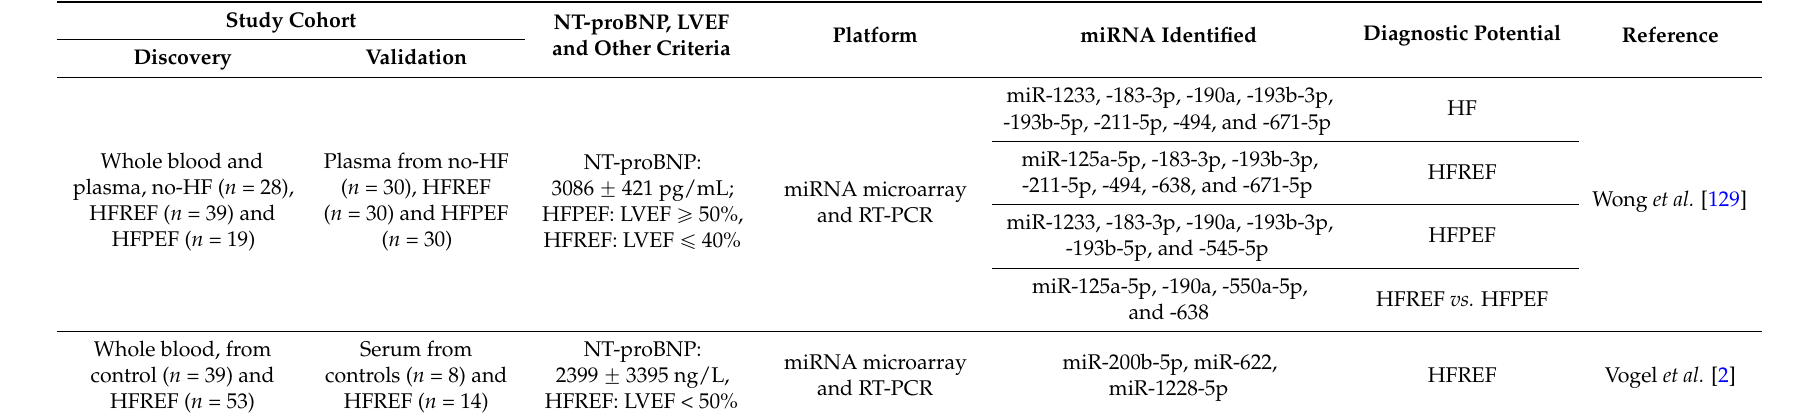
Table 4. Summary of reported miRNAs as HF biomarkers in whole blood